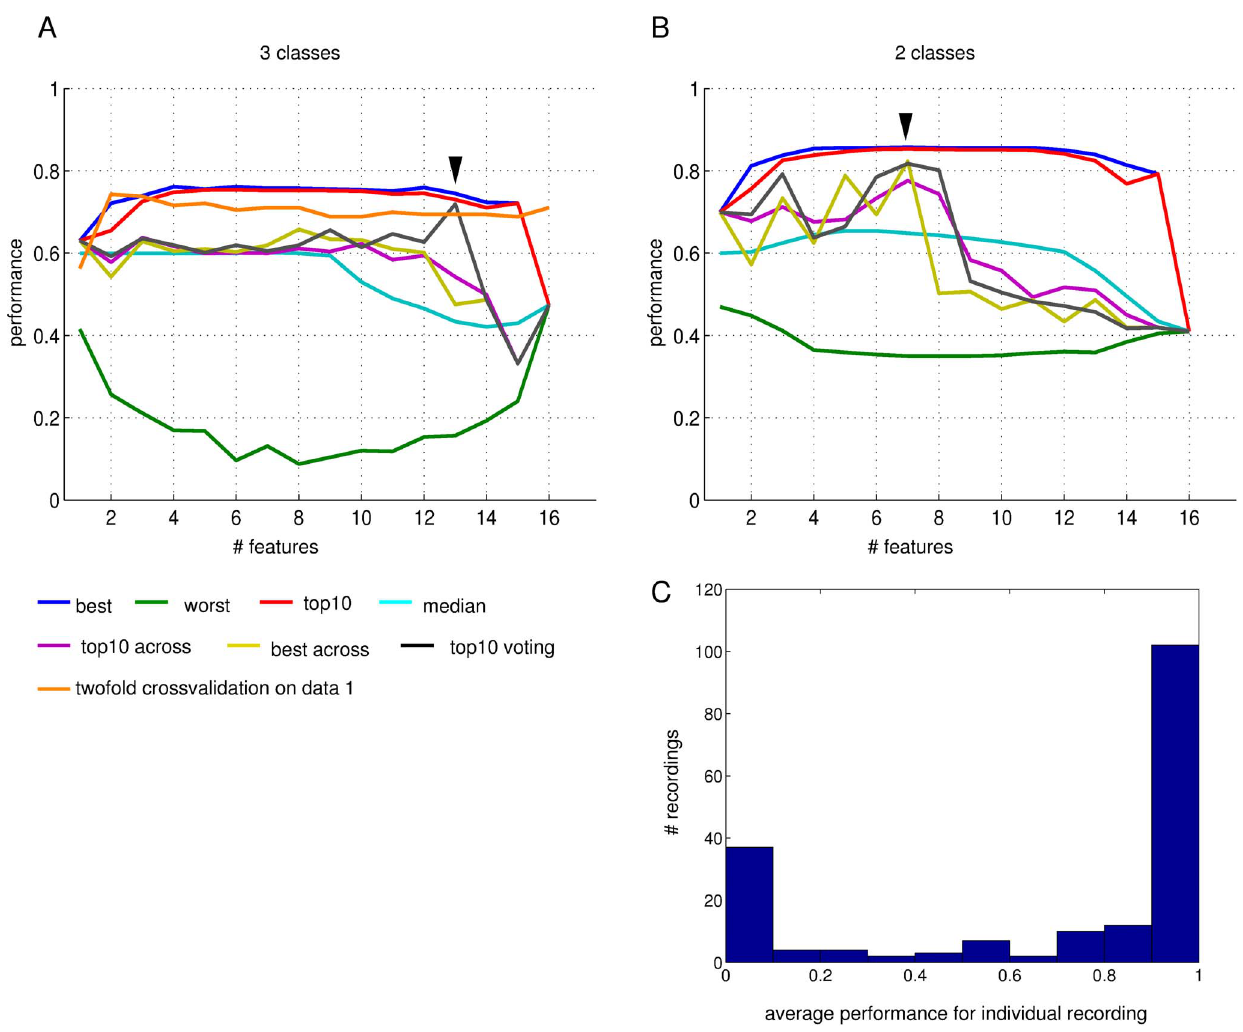
Figure 8. Performance of training classifiers and choosing features on data set 1 and predicting the quality of recordings in data set 2 for the 3-class problem (A) and the 2-class problem (B). The most relevant data are the performance of choosing the best feature set as observed in crossvalidation on data set 1 (blue), training a classifier using this feature set on data set 1 and then predicting the qualities in data set 2 (‘‘best across’’, yellow), the average results of doing so with the members of the top10 group as determined on data set 1 (‘‘top10 across’’, purple) and the result of using a voting scheme within the feature sets of the top10 group (‘‘top10 voting’’, black). Note that for three classes the voting mechanism delivers good performance for 13 dimensional feature sets, while for the 2-class problem 6–8 features appear to be optimal and provide good performance (arrowheads). The red lines show the performance of the top10 feature sets in normal crossvalidation on data set 1. And the green line of the worst feature set. The orange line shows the observed performance of a top10 group of feature sets that are chosen and tested in a two- fold crossvalidation procedure (see methods) and in a sense gives the most accurate prediction of how good a system would do strictly within data set 1. C) Distribution of prediction performance in the two-fold cross-validation procedure with wrapper feature selection on data set 1 resolved by individual recording. The histogram shows how many recordings lead to the performance values marked along the x-axis when being the left out and later classified example in the two-fold crossvalidation. The performance in this context was based on the 10 best feature sets (regardless of size) as found in wrapper feature selection on the n 2 1 data set.